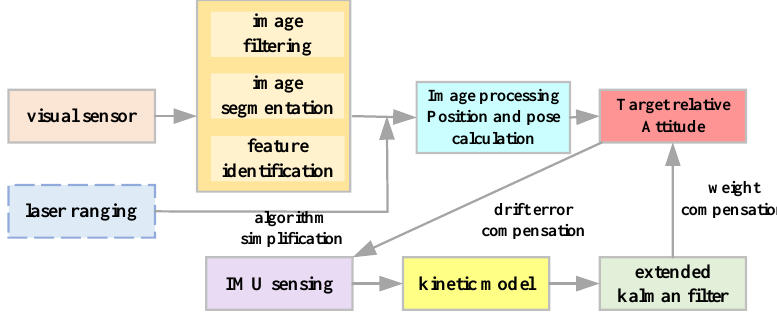
Figure 26. The schematic diagram of vision + inertial navigation + laser measurement.